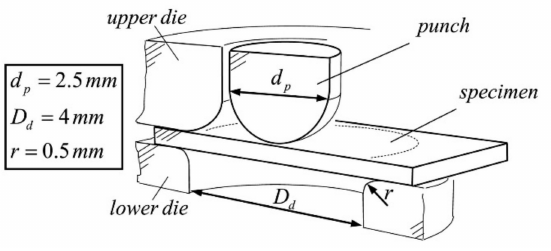
Figure 1. Small Punch testing scheme.